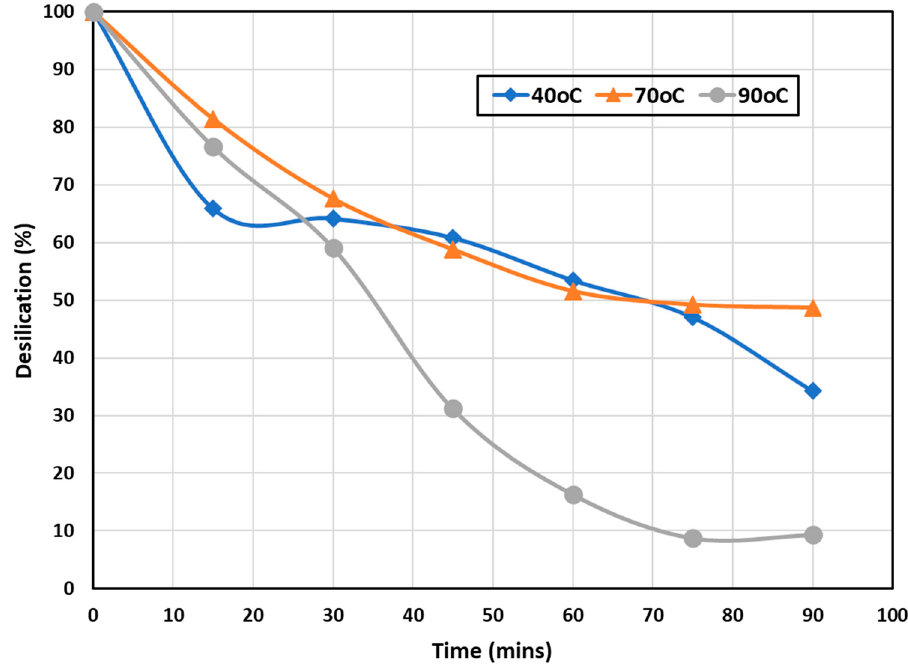
Figure 4. Percentage reduction of Si with time using 6 g CaO at temperatures 40 °C (Test 4), 70 °C (Test 5), and 90 °C (Test 2).